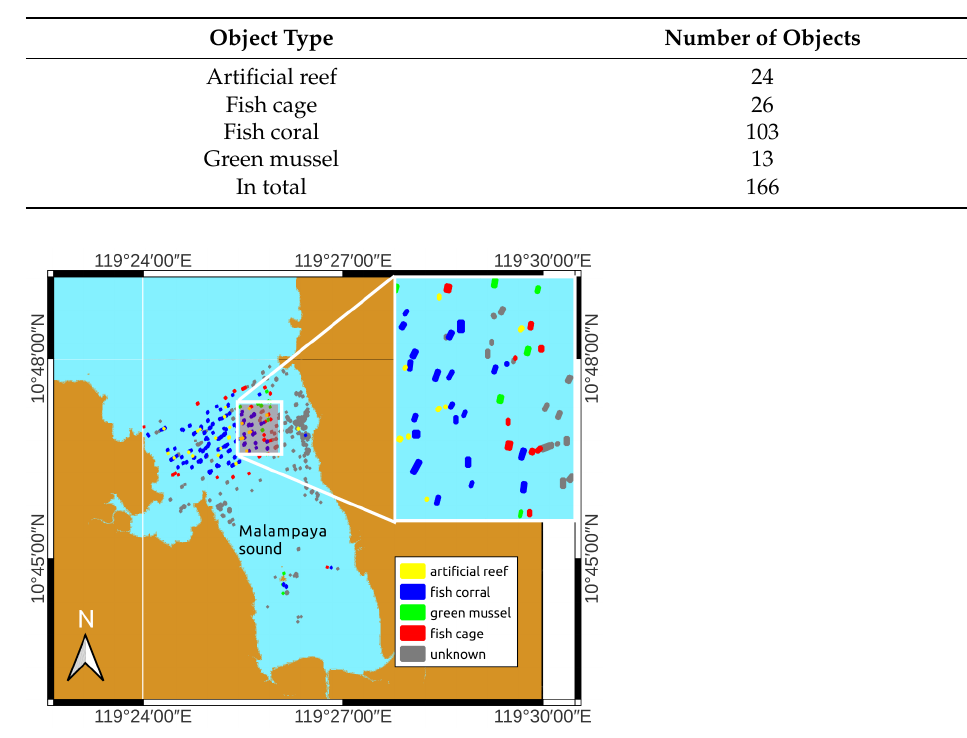
Table 2. Classification of detected objects based on a survey.